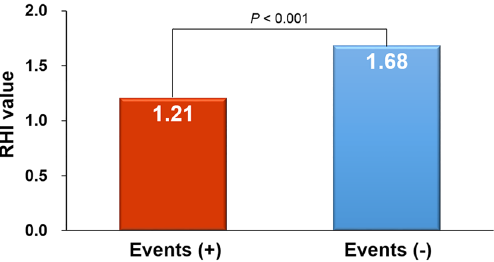
Figure 1. RHI according to the occurrence of clinical events RHI, reactive hyperemia index.